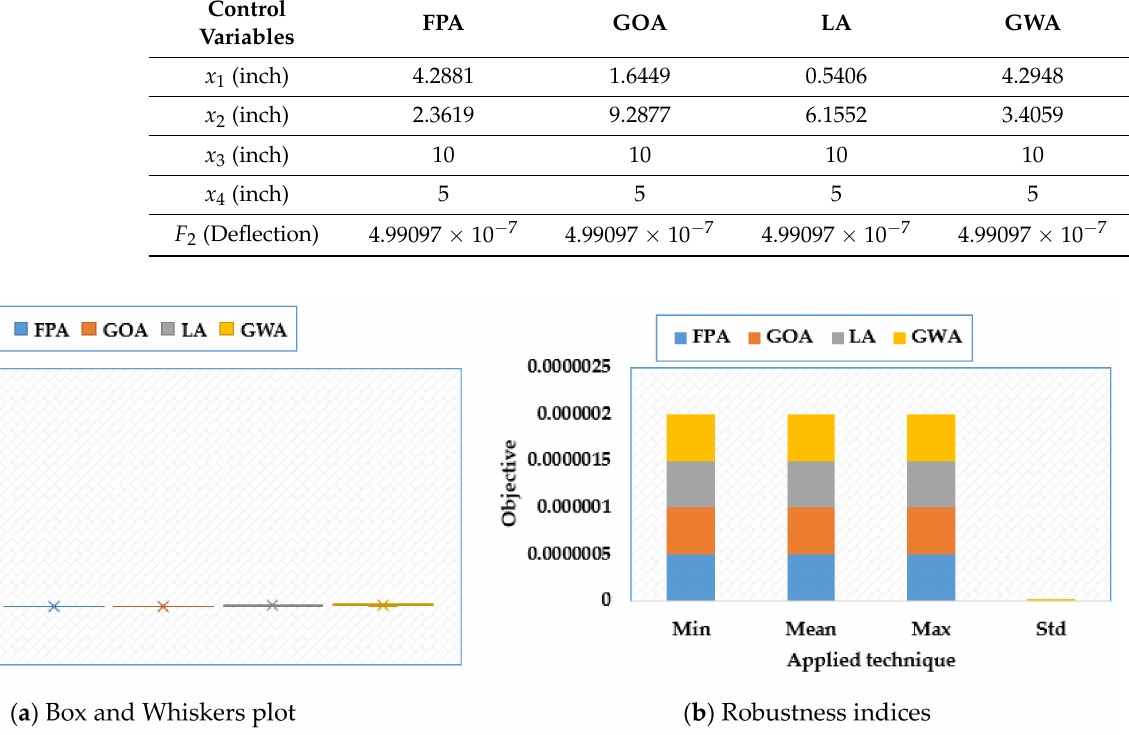
Figure 16. Statistical assessment of GWA, FPA, LA, and GOA for WBD under second case.